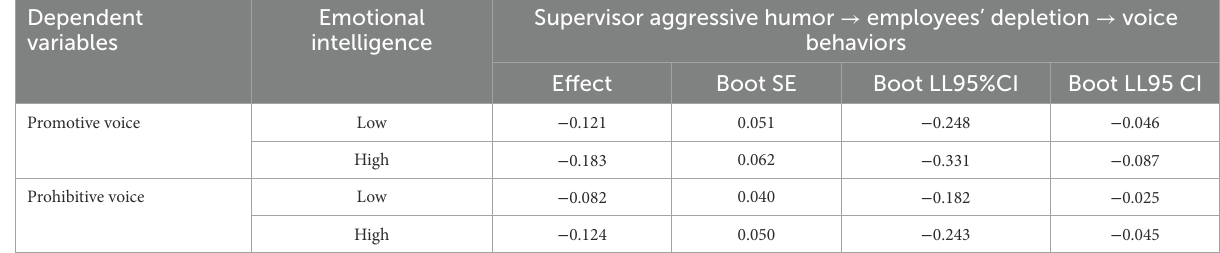
TABLE 6 Results of the moderated path analysis (a).